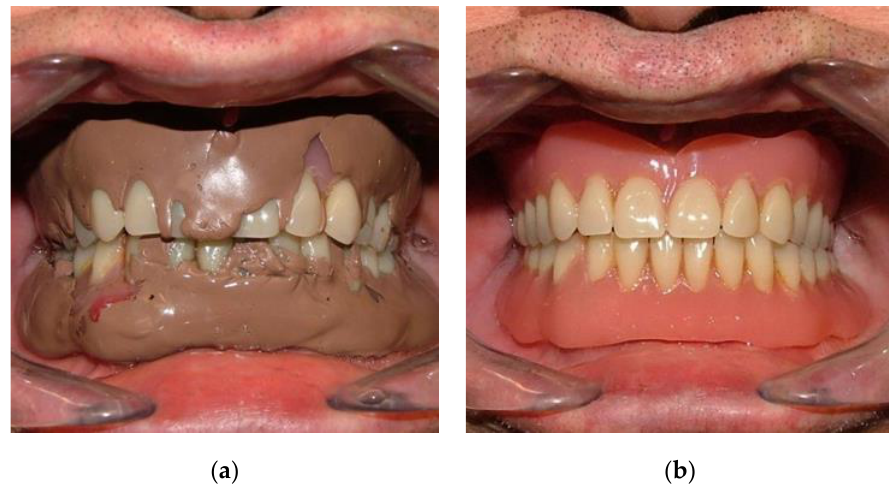
Figure 4. ( a ) Impression with polysulfide to repair and reline; ( b ) prosthesis repaired and relined.